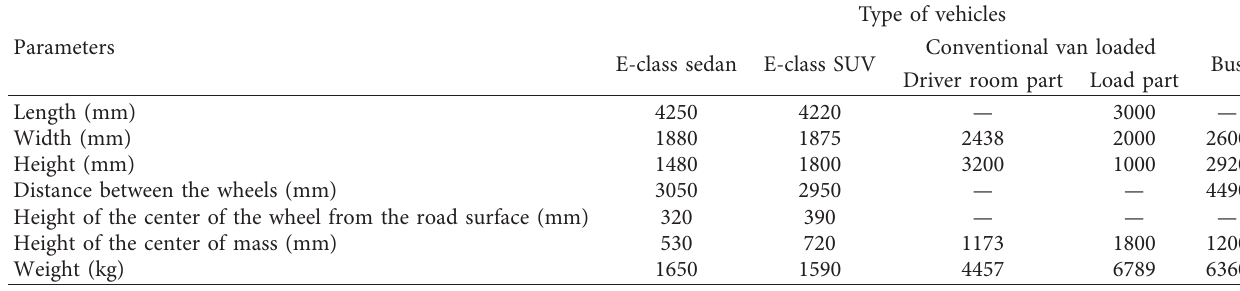
Table 1: Specifications of the vehicle used in the research.